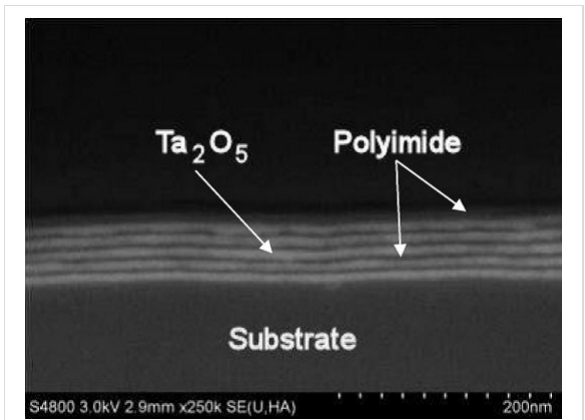
Figure 11: Field emission scanning electron microscopy image of a nanolaminate fabricated using five bilayers of 10 nm Ta 2 O 5 and 10 nm polyimide (reprinted with permission from [62], Copyright (2009) WILEY-VCH Verlag GmbH & Co. KGaA,